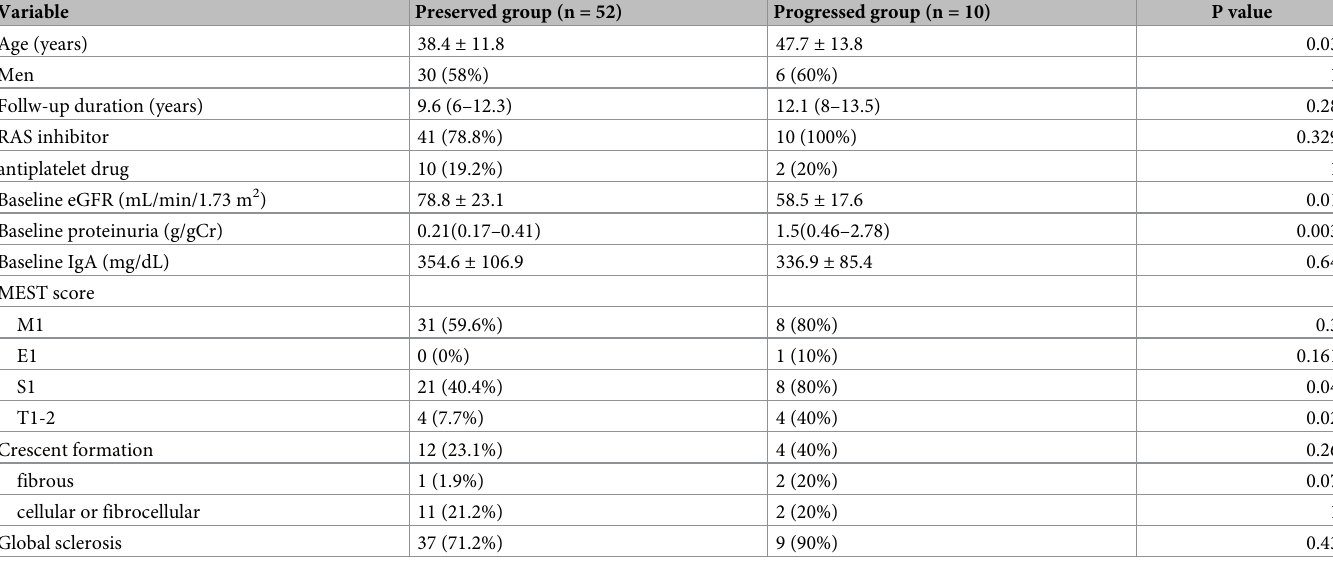
Table 4. Comparison of baseline characteristics between preserved group and progressed